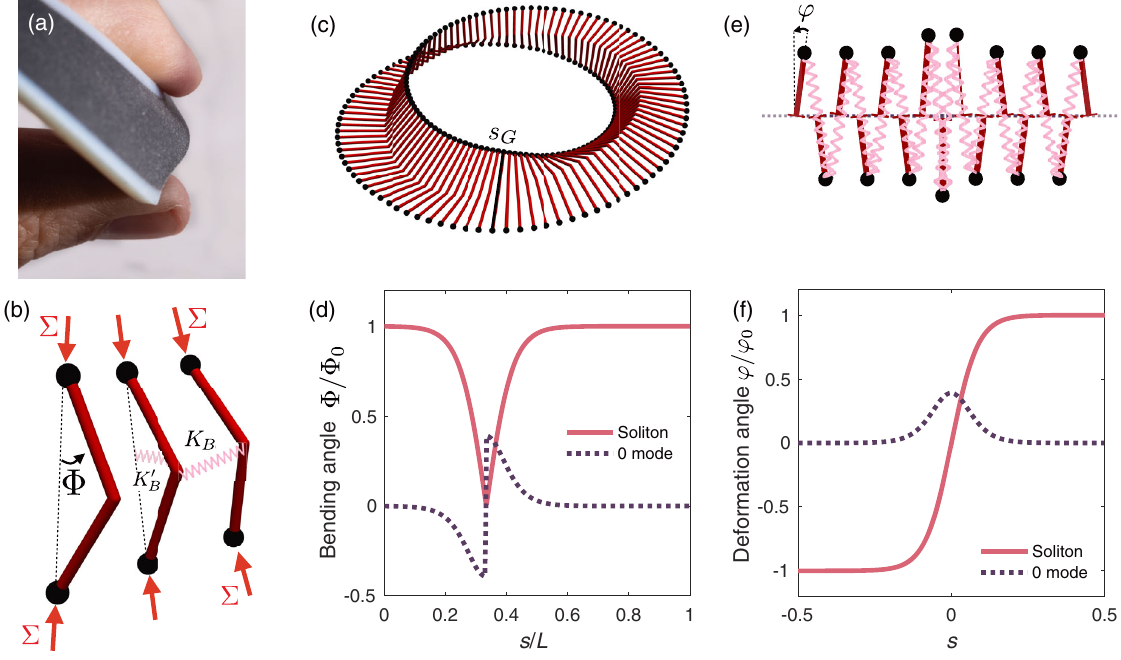
FIG. 6. From buckled a Möbius strip to topological interface states. (a) A 3D-printed Möbius strip buckles upon application of a local compressive stress. (b) Sketch of the simplified buckling-elasticity model. A Möbius ladder is composed of rigid bars of length l connected by soft hinge of stiffness K 0 B . The hinges are themselves coupled by harmonic springs of stiffness K B . The deformation of the Σ indicates the strength of the applied compressive stress. (c) Heterogeneous buckling pattern i th hinge is parametrized by the angle Φ i . of a Möbius ladder. The location of the undeformed bar at s ¼ s G is indicated with a dark color. Φ 0 ¼ π = 6 , ξ ¼ L= 5 . (d) Solid line: Shape of the soliton, i.e., variations of the bending angle Φ B ð s Þ . s G topologically protects the strip from homogeneous bending. Dashed line: Shape of the floppy mode bound to the solitonic excitation. Φ 0 ¼ 1 , ξ ¼ 0 . 12 L . (e) Sketch of the mechanical Su Schrieffer Heeger (SSH) model introduced in Ref. [3]. This simple mechanical metamaterial is composed of a canted rigid bar free to rotate around a single axis connected by harmonic springs; see Ref. [9] for an experimental realization. (f) Solid line: The interface between two topologically distinct mechanical metamaterials is a ϕ 4 kink. Dashed line: Topological interface mode of the SSH model. φ 0 ¼ 1 , ξ ¼ 0 . 12